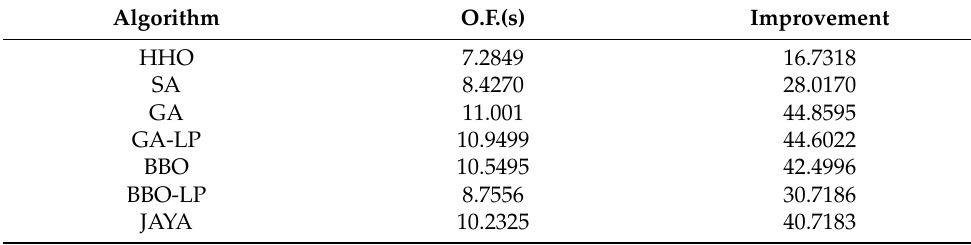
Table 6. Current transformer ratio. Relay No.